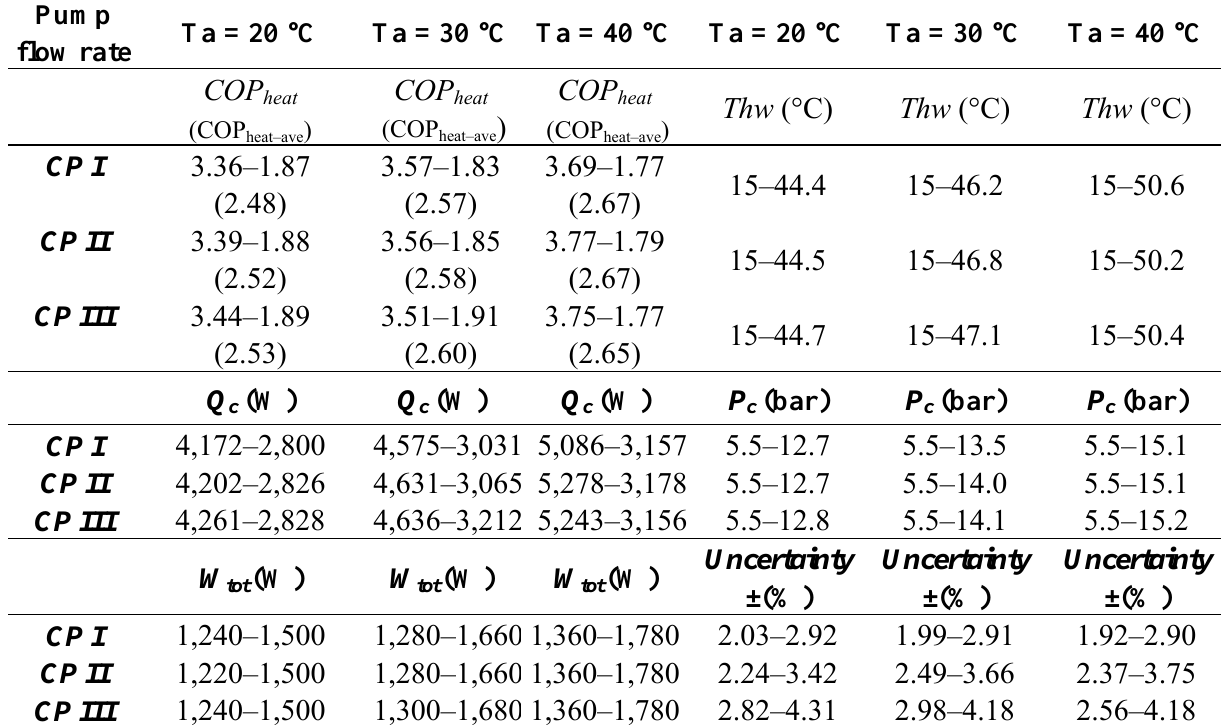
Table 3. The change and evaluation of the parameters for different pump flow rates duration 90